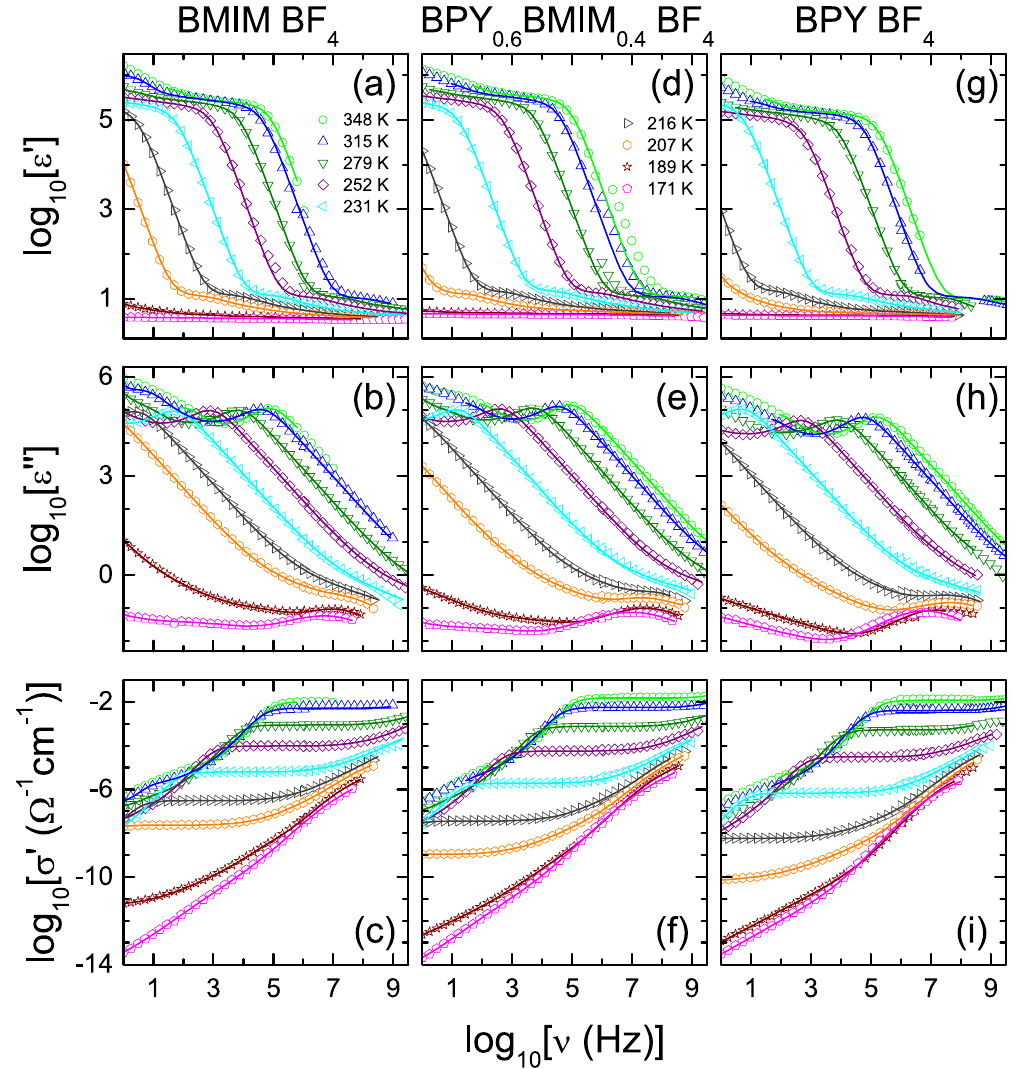
Figure 2. Dielectric spectra of ionic liquids and their mixture. Frequency dependence of permittivity ε ′ , dielectric loss ε ′′ and conductivity σ ′ of BMIM BF 4 ( a – c ), BPY 0.6 BMIM 0.4 BF 4 ( d – f ) and BPY BF 4 ( g – i ). The lines are simultaneous fits of ε ′ and ε ′′ with two distributed RC circuits 36 in series with dc conductivity and the sum of three intrinsic relaxations 37 . The temperatures for all frames are denoted in ( a ) and ( d